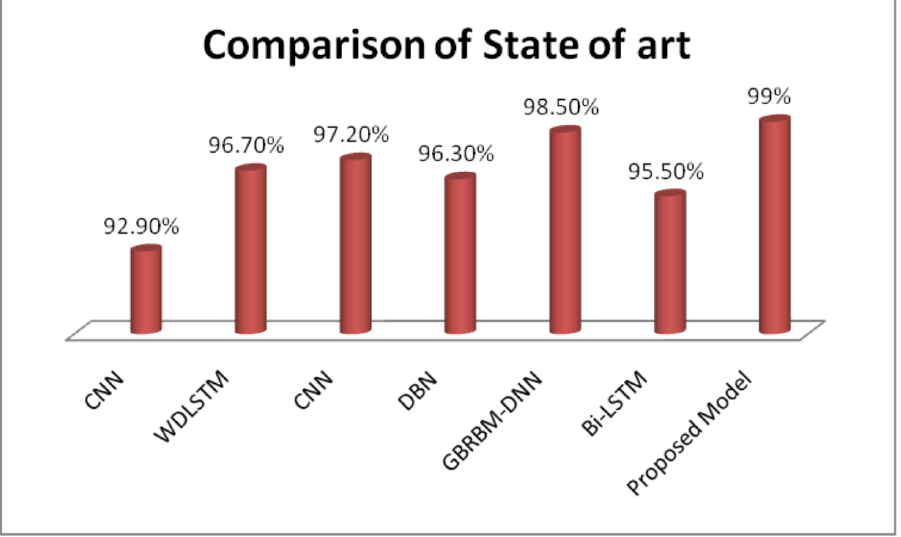
Figure 9. Comparison with the state-of-the-art